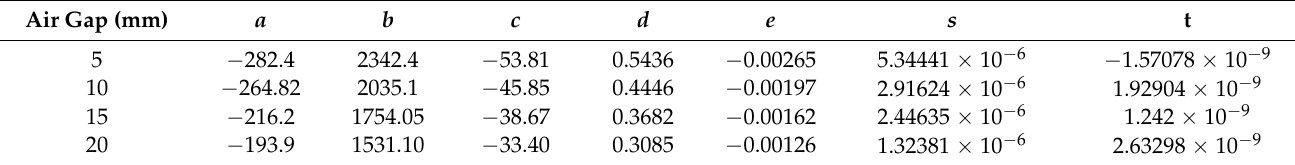
Table 2. Coefficient of braking force fitting curves under different working air